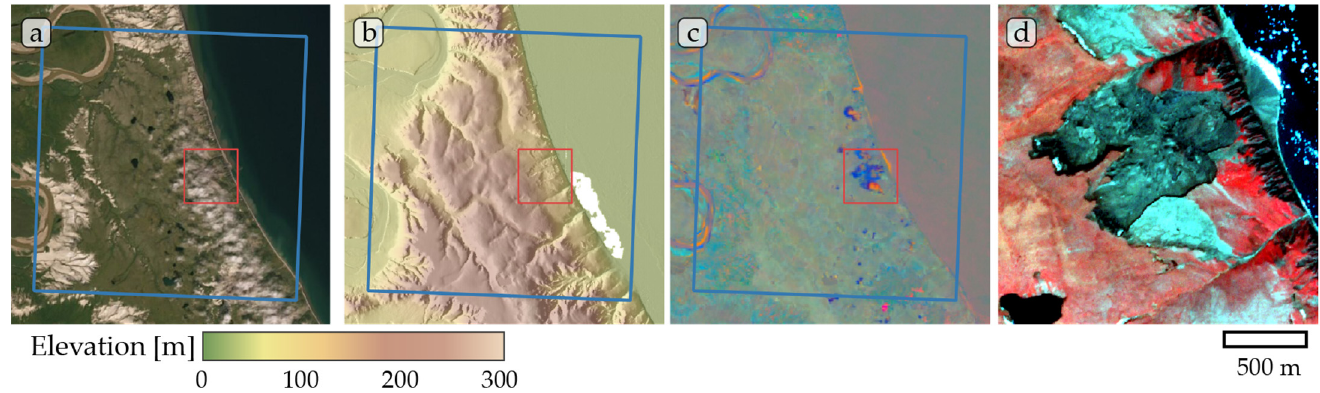
Figure A4. Study site Horton 01. ( a ) ESRI satellite layer, ( b ) ArcticDEM superimposed with hillshade, ( c ) Tasseled Cap trend visualization, ( d ) PlanetScope satellite image (NIR-R-G) acquired on 14 July 2019. Blue box, 10 × 10 km study site. Red box detailed view of ( d ).